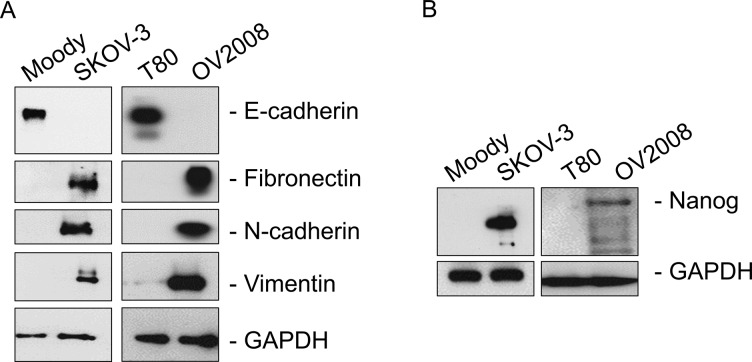
NANOG is overexpressed in ovarian cancer cells that express proteins’ characteristics of EMT(A) Whole-cell lysate prepared from epithelial ovarian cancer cells, SKOV-3 and OV2008, and normal epithelial ovarian cells, Moody and T80, were probed with indicated antibodies against known epithelial (E-cadherin) and mesenchymal cell (vimentin and fibronectin) markers. The blots were probed with anti-GAPDH antibody to confirm equal loading. (B) Same as (A) except for that the blot was probed with NANOG antibody.